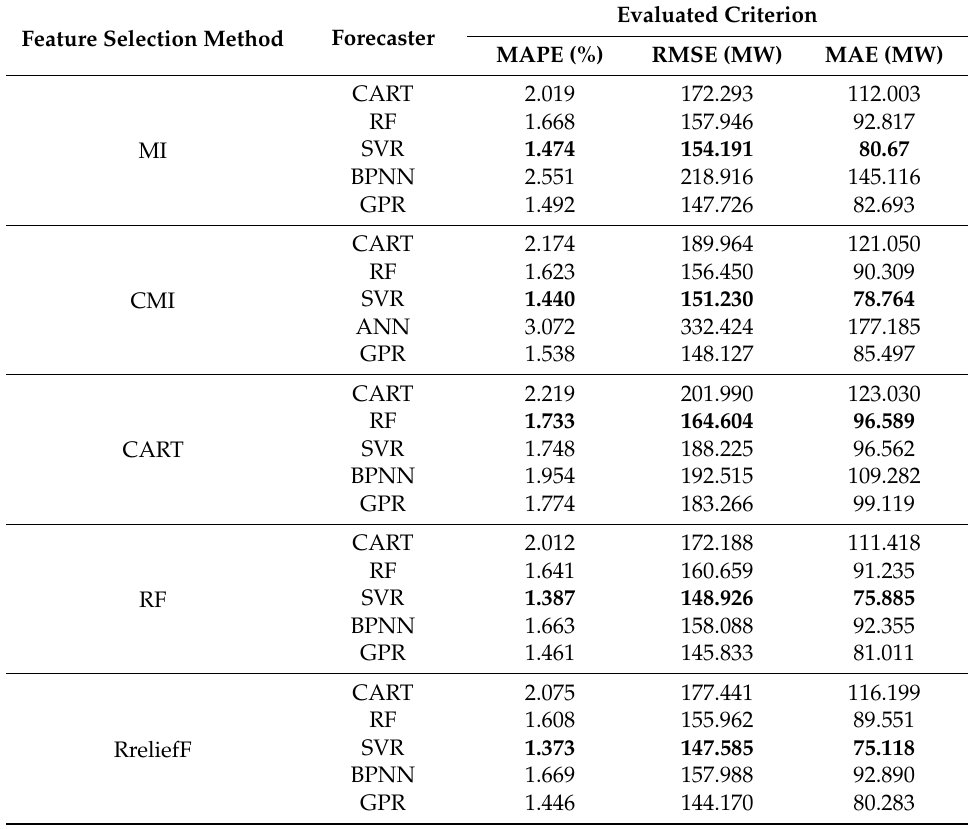
Table 13. Error of load forecasting of different methods with proposed forecasting strategy for the whole test